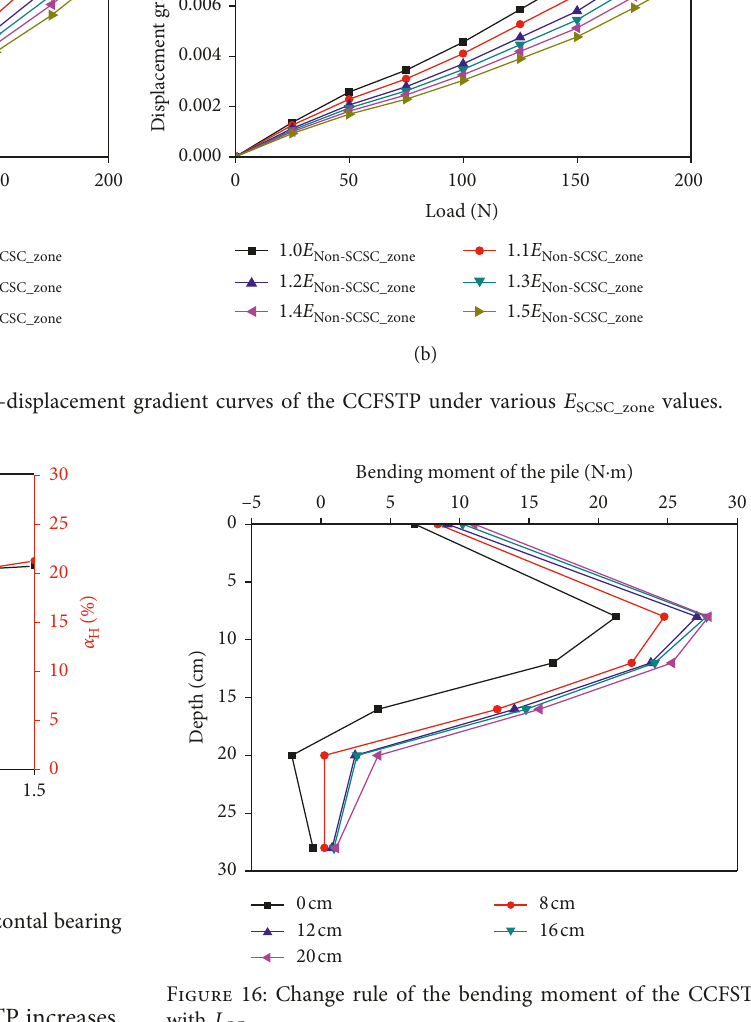
Figure 16: Change rule of the bending moment of the CCFSTP with L SC